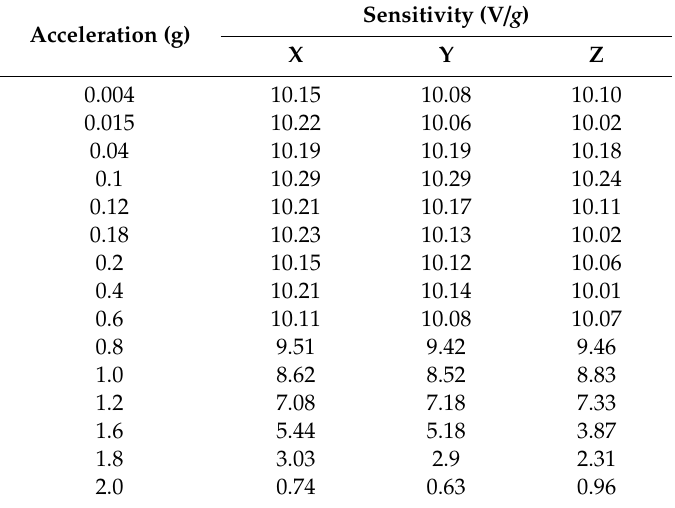
Table 3. The adaptive sensitivities with the amplitudes of inputs.